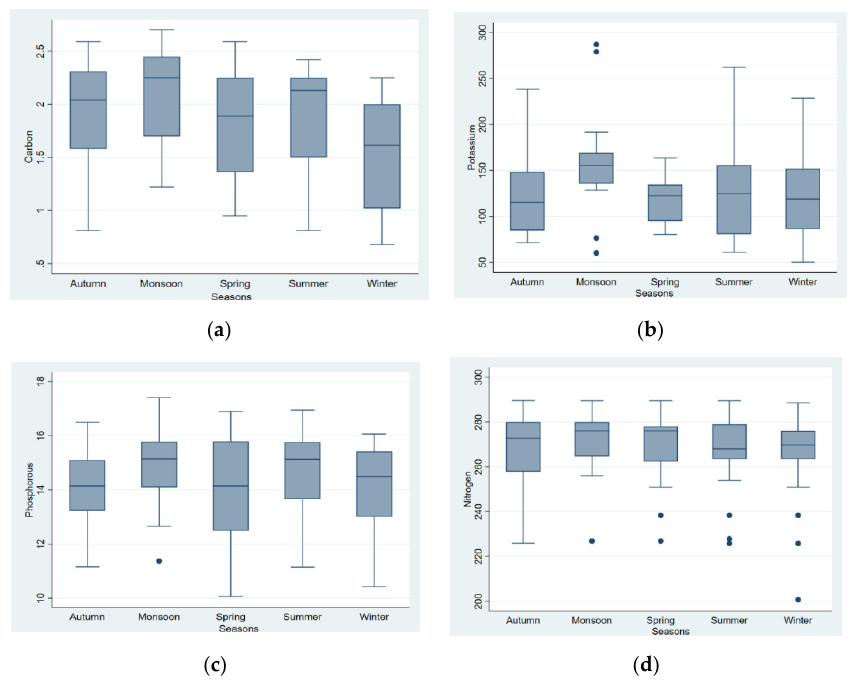
Figure 6. ( a ) Season-wise carbon concentration (%), ( b ) season-wise available potassium concentration (kg/ha), ( c ) season-wise available phosphorous concentration (kg/ha), ( d ) season-wise available nitrogen concentration (kg/ha); the blue dotes (outliers) in all figures are used show some anomalous results were observed in